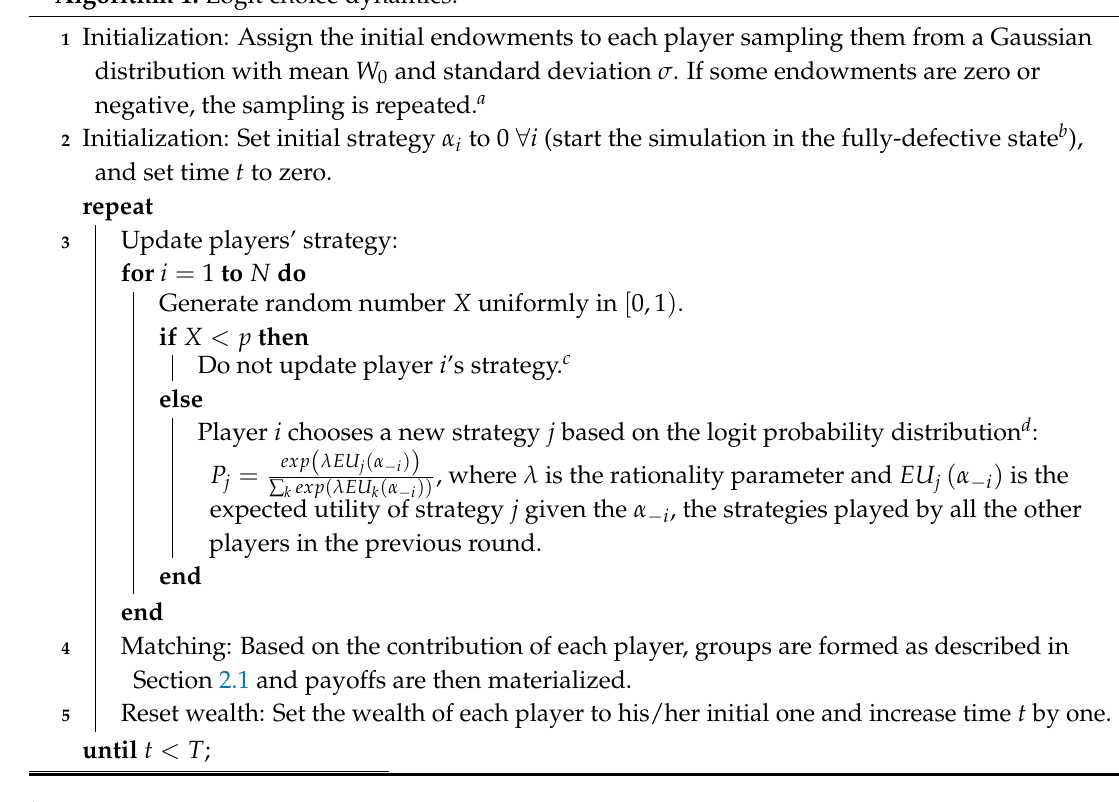
Algorithm 1: Logit choice